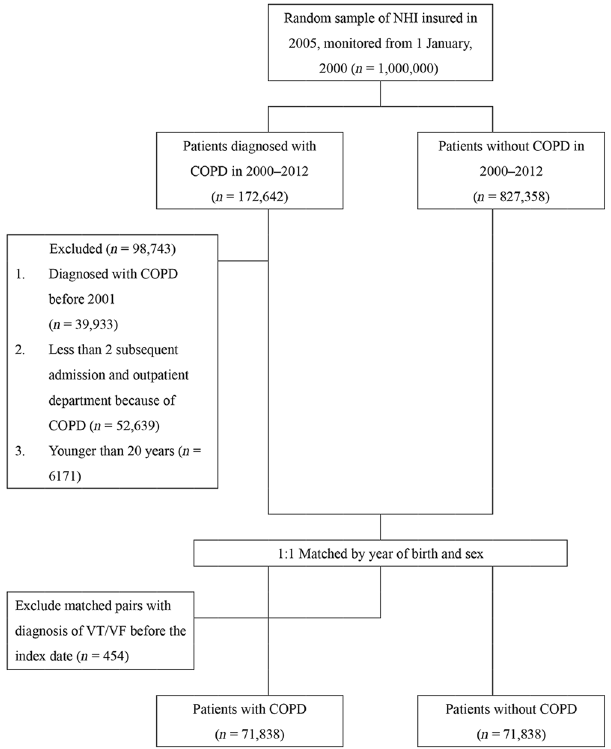
Fig. 1 Data selection process. Patients with newly diagnosed COPD since 2001 were matched with controls without COPD at the same index date as the date of diagnosis of